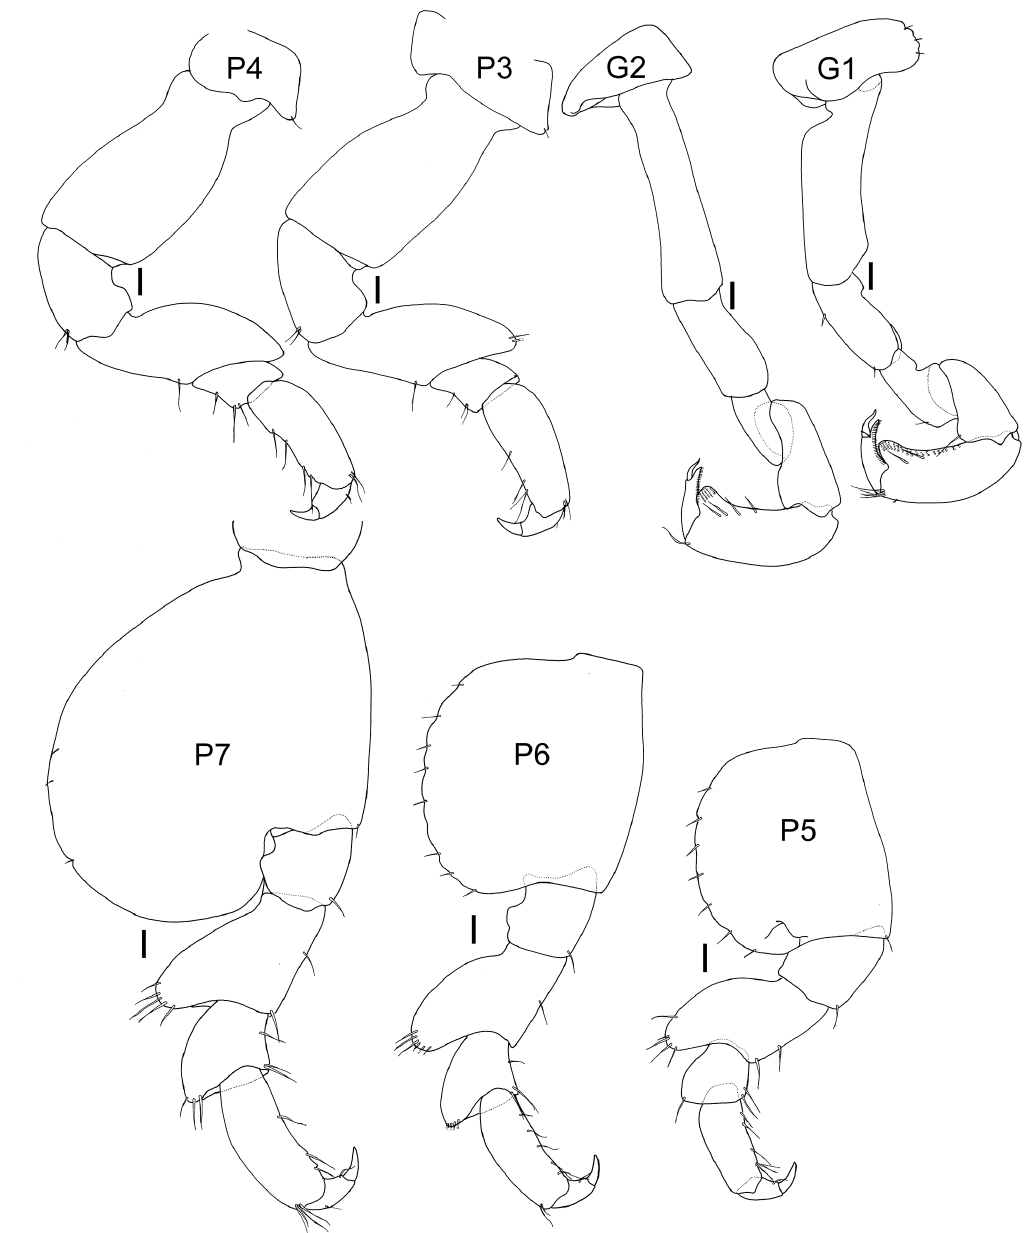
Figure 2. Bircenna hinojosai sp. nov. Holotype female, 6 mm, AM P.100648, Bicheno, Tasmania, Australia. Scale bars: 0.1